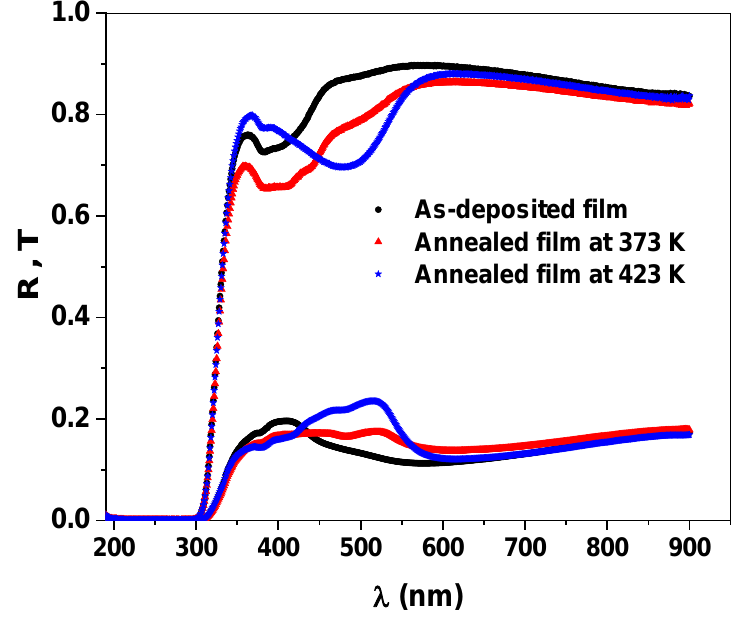
Figure 12. Optical transmittance (T) and reflectance (R) of compound 4 thin